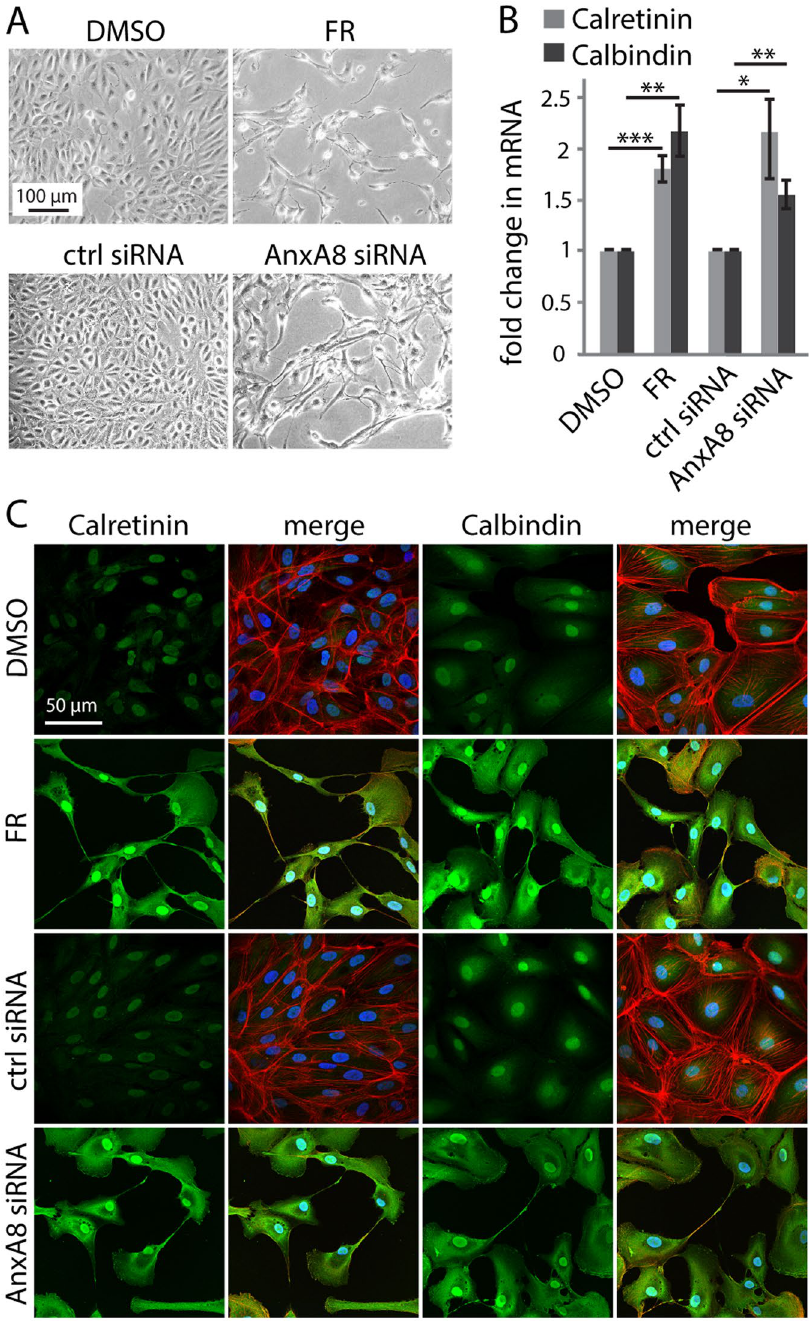
Figure 3. Loss of AnxA8 leads to up-regulation of neuronal markers in RPE cells. ( A ) Phase images of FR- or AnxA8 siRNA-treated ARPE-19 cells show reduced cell growth and formation of neuronal-like extensions compared to respective controls. Experiments were performed three times and representative images are shown, scale bar = 100 μ m. ( B ) mRNA was extracted from ARPE-19 cells following treatment with FR or AnxA8 siRNA and subjected to real-time PCR analysis for calretinin and calbindin. The results show that both genes were significantly up-regulated by FR and AnxA8 siRNA ( ** = P < 0.01, *** = P < 0.001, n = 4). ( C ) ARPE-19 cells were treated with FR and AnxA8 siRNA, then fixed, immunostained and visualized by confocal microscopy. Calretinin and calbindin (both green) were stained along with nuclei (DAPI, blue) and F-actin (rhodamine phalloidin, red). Calretinin and calbindin staining in cells treated with FR and AnxA8 siRNA was markedly enhanced and more evident in the cytosol, scale bar = 50 μ